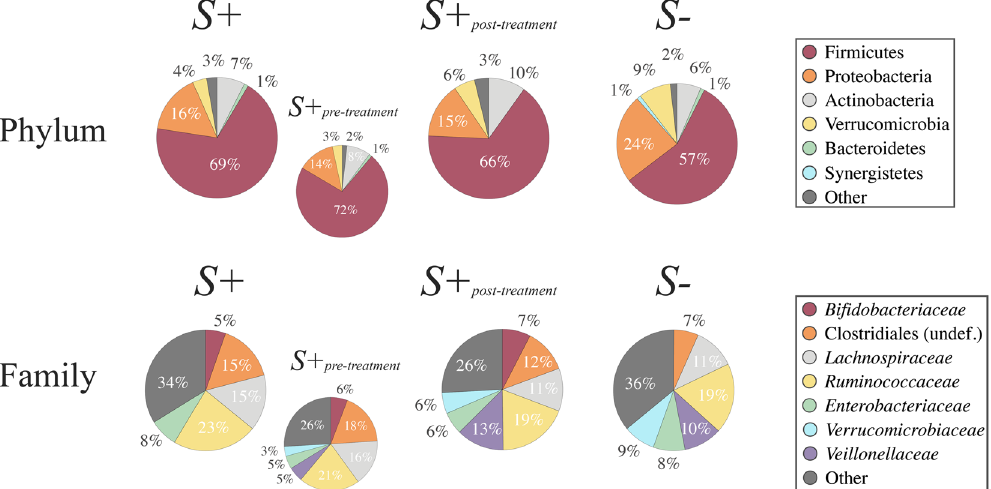
Figure 1. Firmicutes and Proteobacteria are most abundant phyla in the faecal microbiota of all study subjects. Relative abundances of bacterial phyla and families detected in faecal samples from Strongyloides stercoralis infected and uninfected subjects ( S + and S − , respectively) and of the subset of S + subjects that had received anthelmintic treatment (associated sub-circles), both prior to ( S + pre-treatment ) and 6 months post-ivermectin administration ( S + post-treatment ). Percentages in individual pie chart sections indicate the relative proportion of a given bacterial phylum or family.